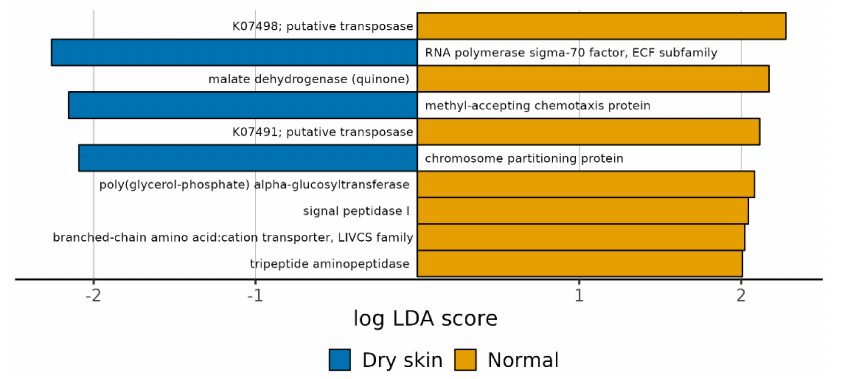
Figure 11. Computed LDA scores of the significantly different functions in normal and dry skin groups. Negative LDA scores (blue) are enriched in the dry skin group while positive LDA scores (yellow) are enriched in the normal